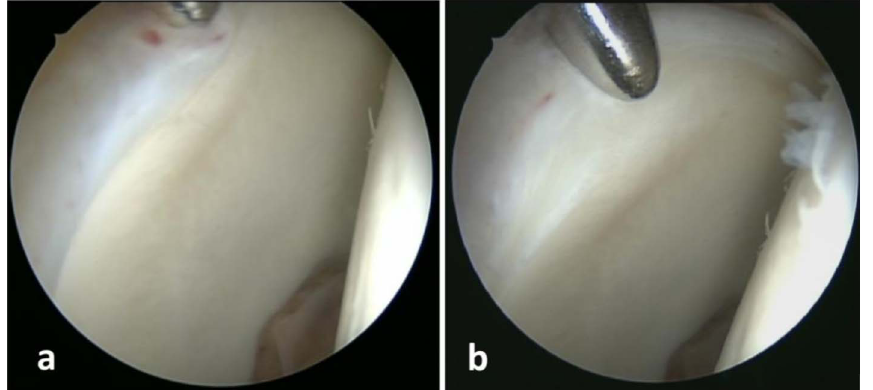
Figure 4. Central compartment of right hip viewed from the anterolateral portal, switching stick is introduced through the anterior portal (a). Cartilage debonding as the stick is pushed against the chondrolabral junction with lesion extending between 1 and 3 O ’ clock (group 1 cartilage damage) (b).